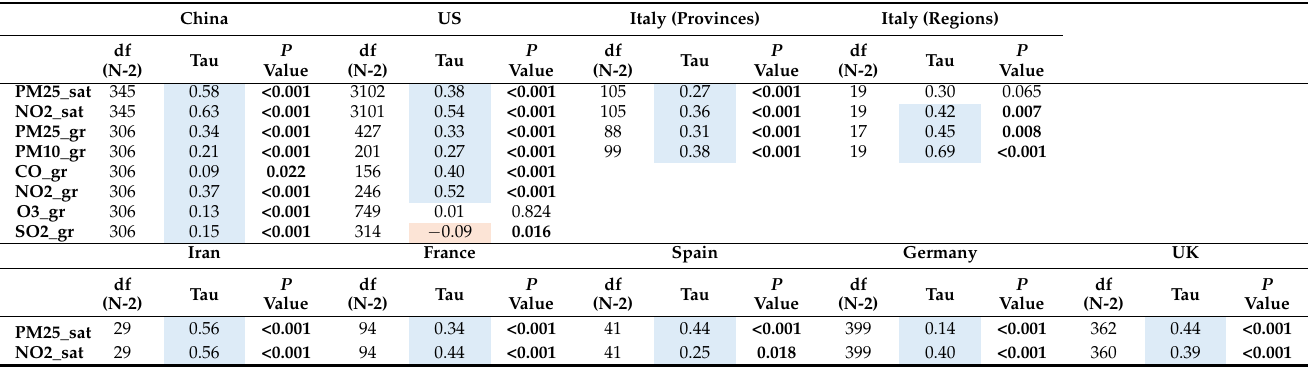
Table A2. Correlation coefficients between population density and air pollution variables in the eight analysed countries. Significant correlations ( p -value < 0.05) are shown in bold; blue and red colour highlights indicate positive and negative correlations,